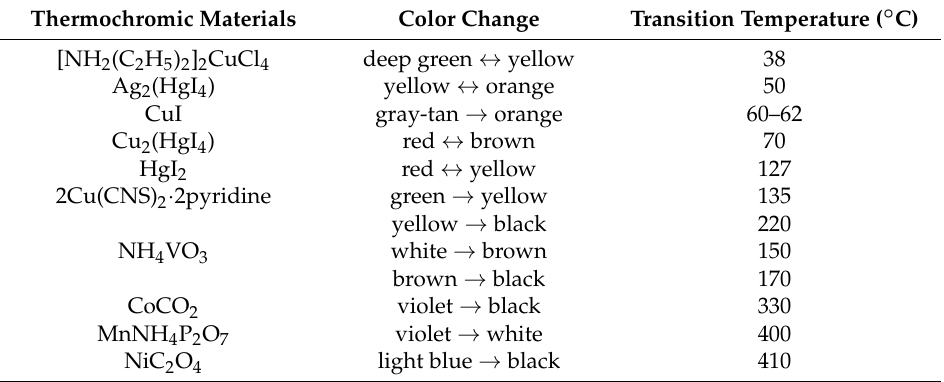
Table 1. Thermochromic materials, their reversible ( ↔ ) or irreversible ( → ) color change, and transition temperatures [13]. Thermochromic